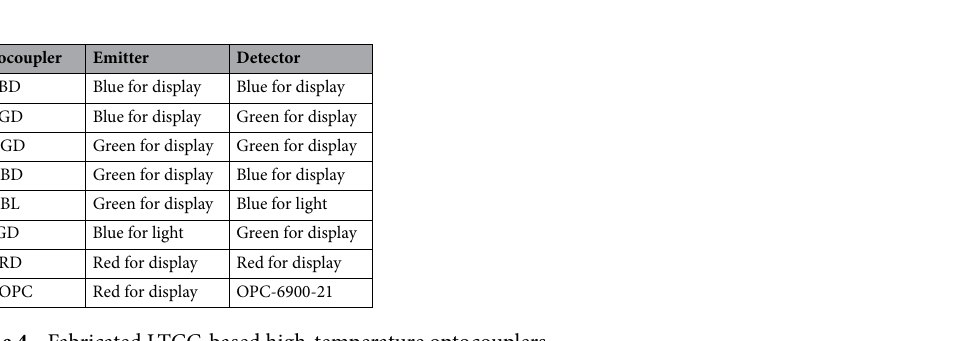
Table 4. Fabricated LTCC-based high-temperature optocouplers.